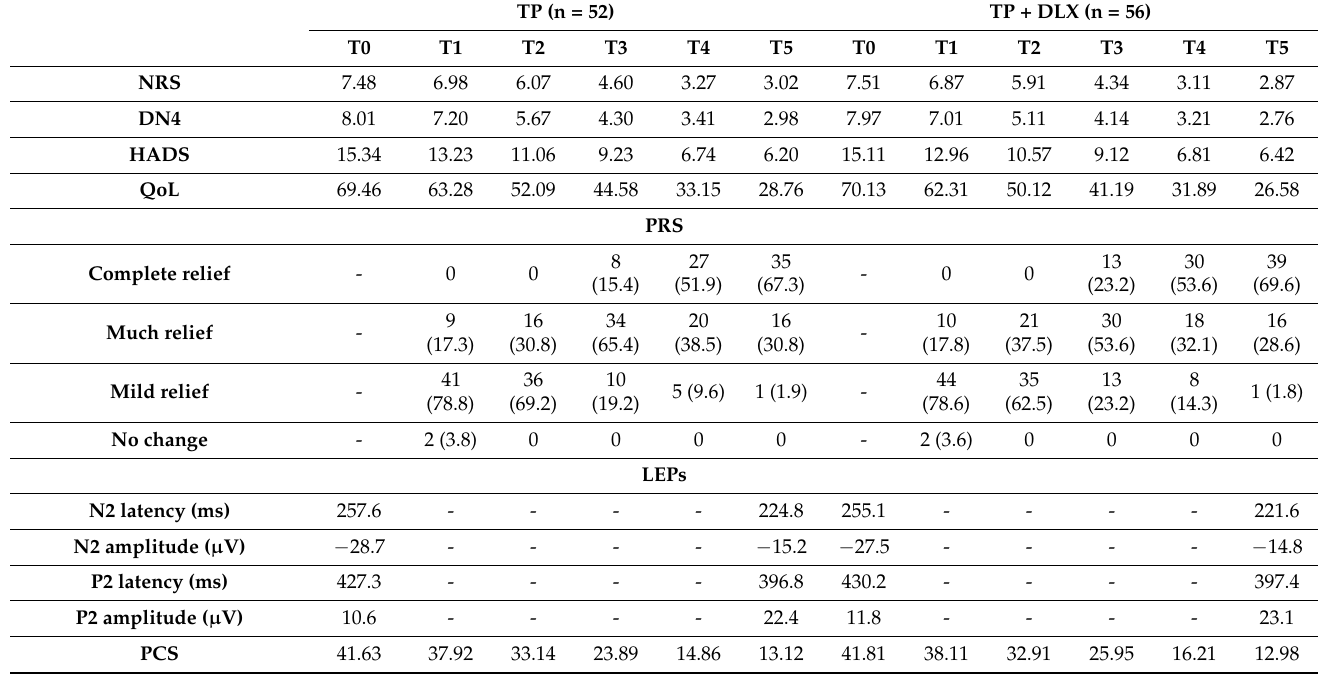
Table 2. Study data at baseline (T0) and at 7 (T1), 14 (T2), 21 (T3), 28 (T4), 42 (T5) days after treatment.